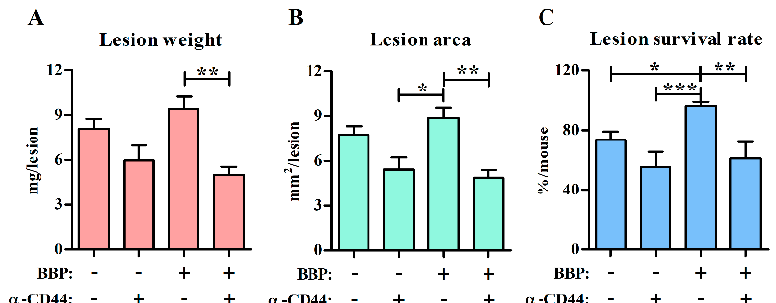
Figure 4. Effect of CD44 blocking on lesion growth. Lesions were harvested after 4 weeks from the control and BBP-treated (1.5 mg BBP/kg BW/day) mice. Each mouse was treated with blocking antibody against CD44 on one side (+) and isotype control antibody on the other side (–) at the implantation sites on the day of surgery. ( A − C ) Lesion weight ( A ), lesion area ( B ), and lesion survival rate ( C ) per mouse are shown as the mean ± SEM for each group ( n = 9–13 mice/group from four independent experiments). * p < 0.05, ** p < 0.01 and *** p < 0.001 by one-way ANOVA followed by Tukey’s multiple comparison test.